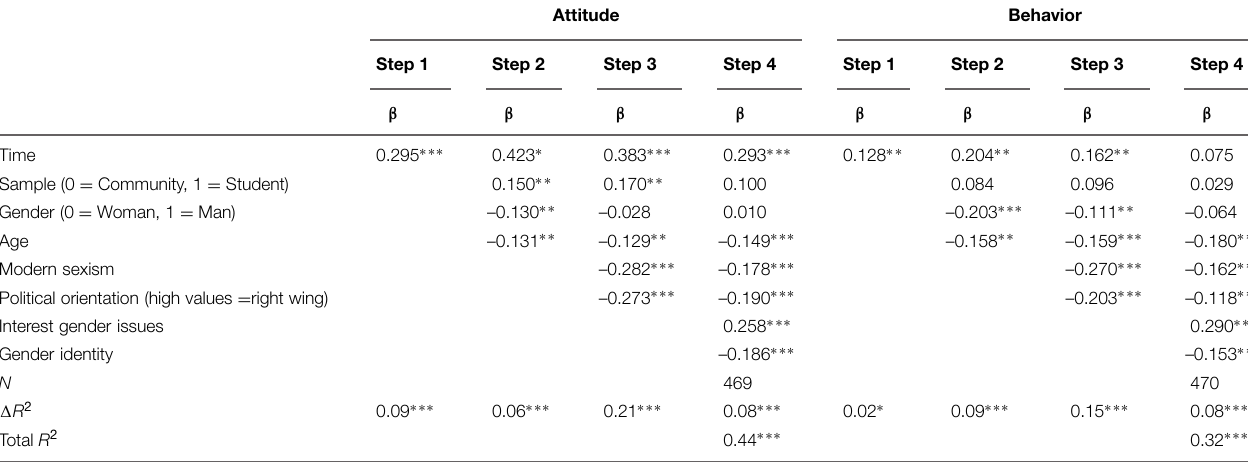
TABLE 7 | Hierarchical multiple regression predicting attitude to and use (behavior) of a gender-neutral pronoun hen .